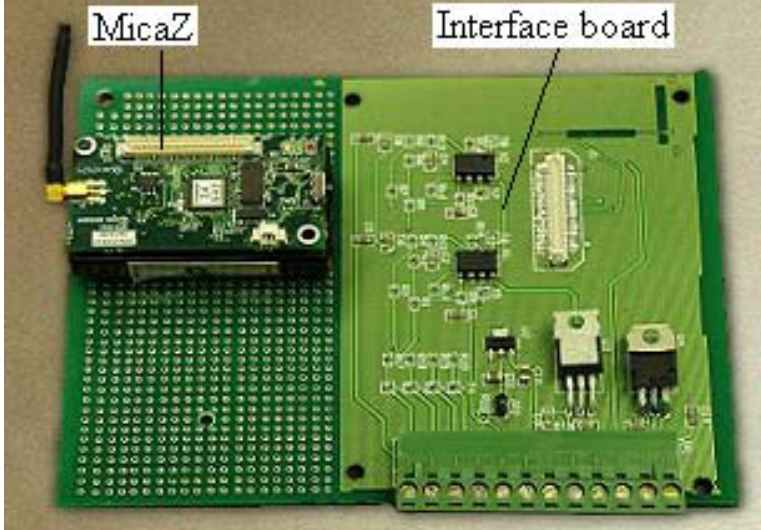
Figure 3. The interface board and the MicaZ for the e-nose.